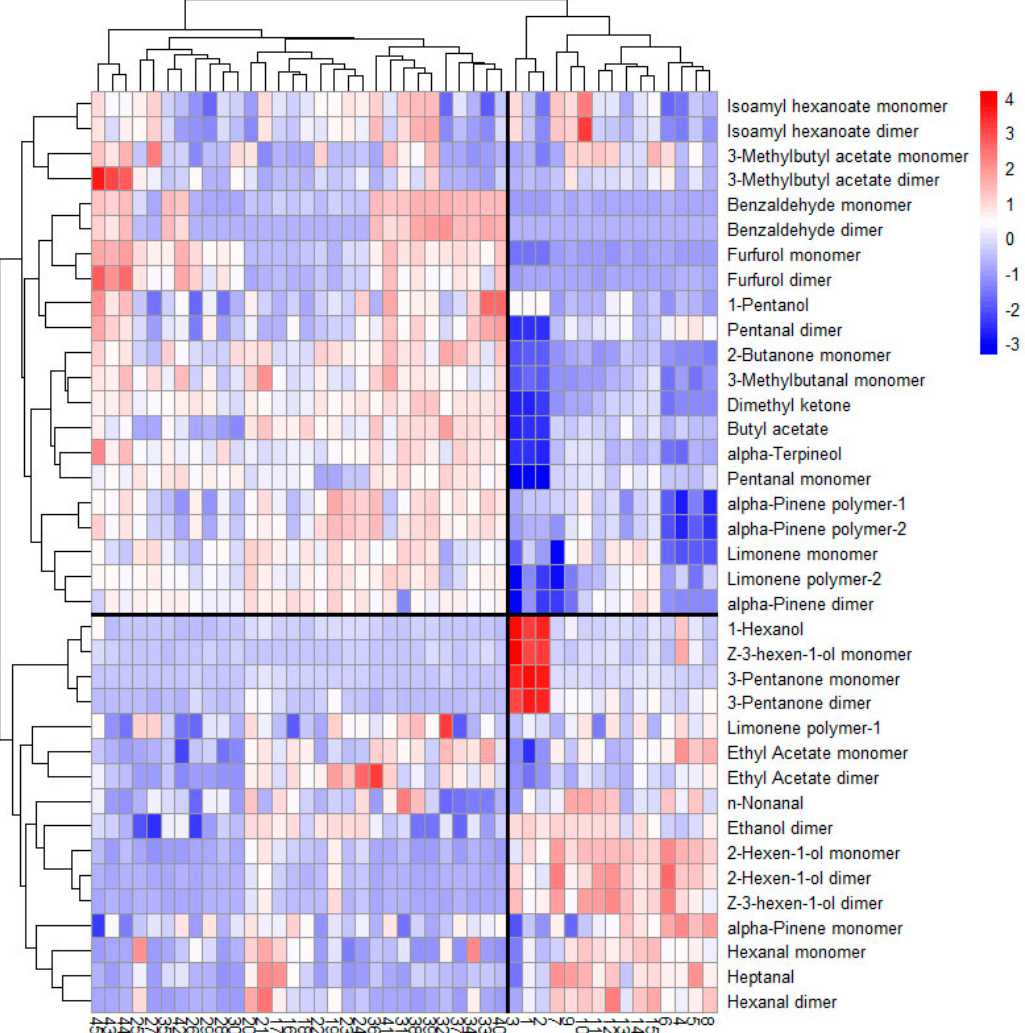
Figure 8. Heat map visualization and clustering results of the volatile constituents of different kumquat types.